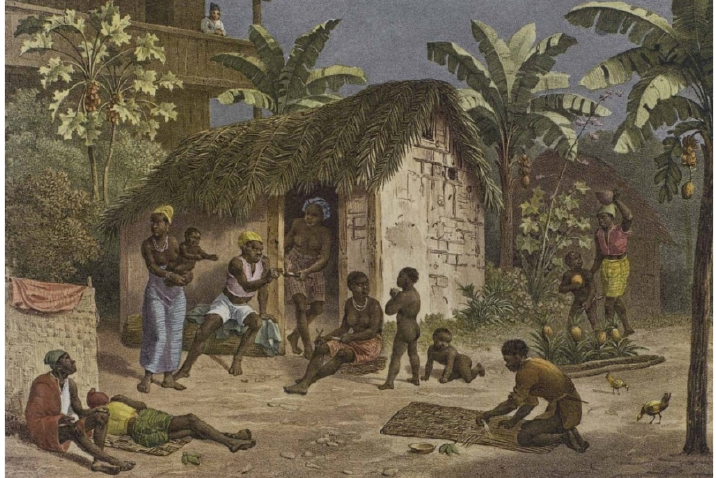
Figure 2. Accommodation and clothing of 19th-century enslaved people (M. Rugendas 1835).